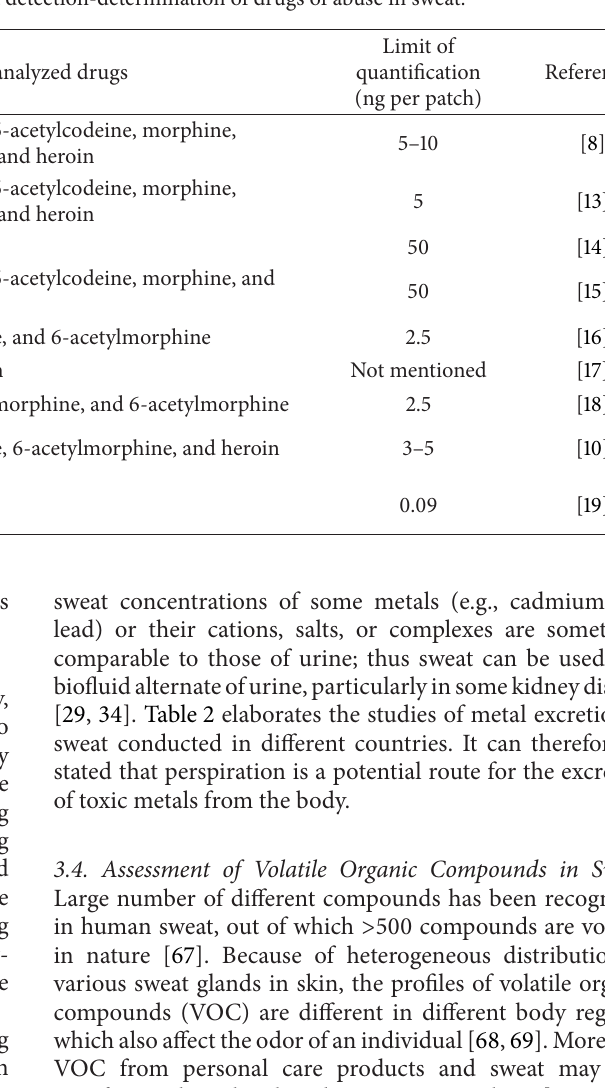
Table 1: Some approaches for separation and detection-determination of drugs of abuse in